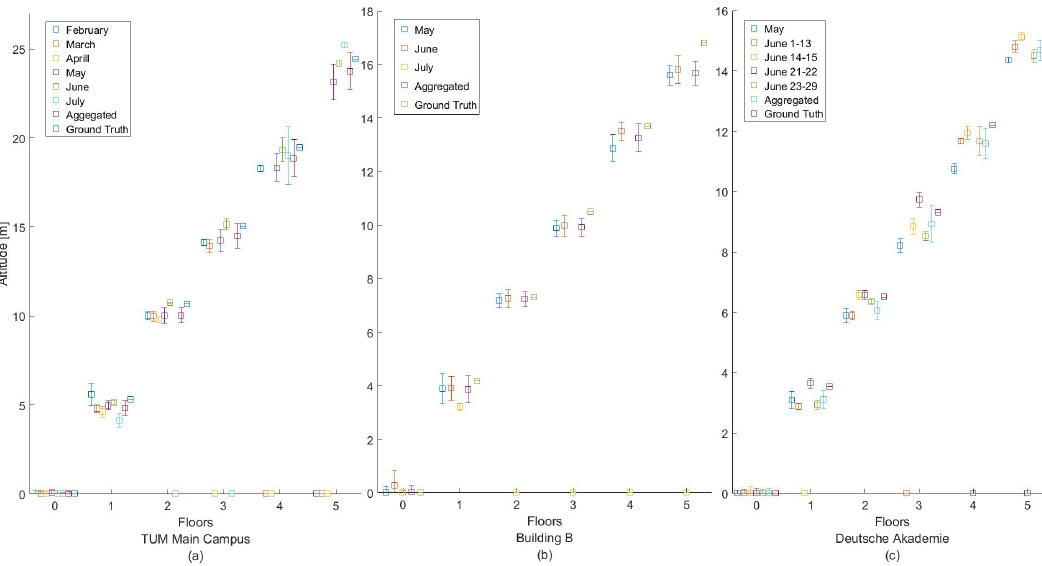
Figure 16. Estimated altitude and ground truth for each floor height for three test buildings ( a ) TUM